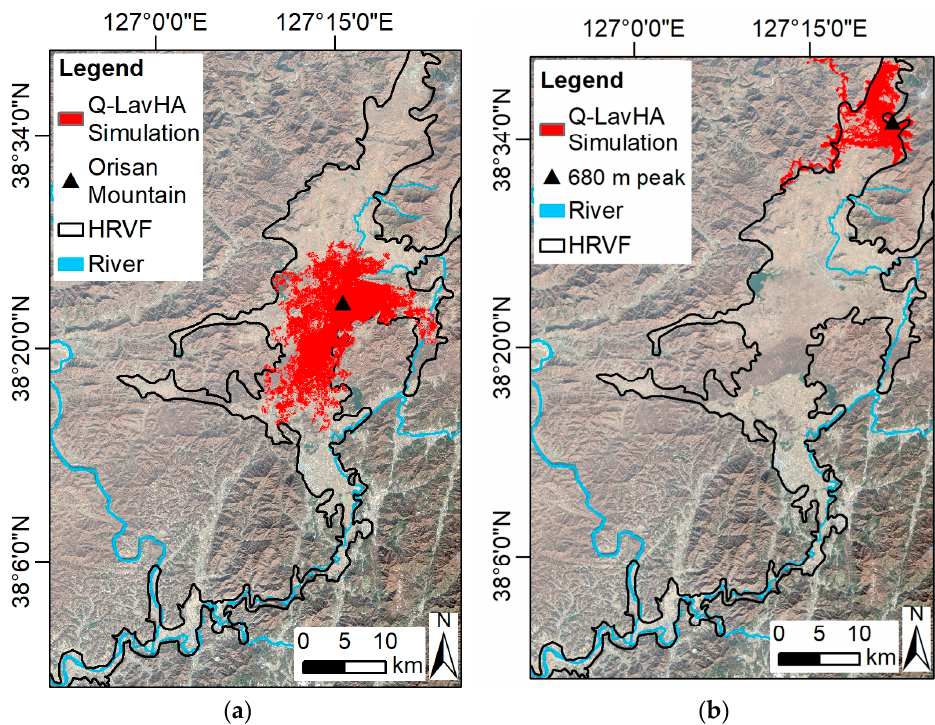
Figure 8. Experimental results: ( a ) Orisan Mountain eruption; ( b ) 680 m peak eruption. The simulated lava flow is displayed with Sentinel-2 satellite imagery acquired from 20 September 2017. Table 2. Comparison of evaluation criteria between the Orisan Mountain and 680 m peak eruptions compared with the ground truth data (of the HRVF).